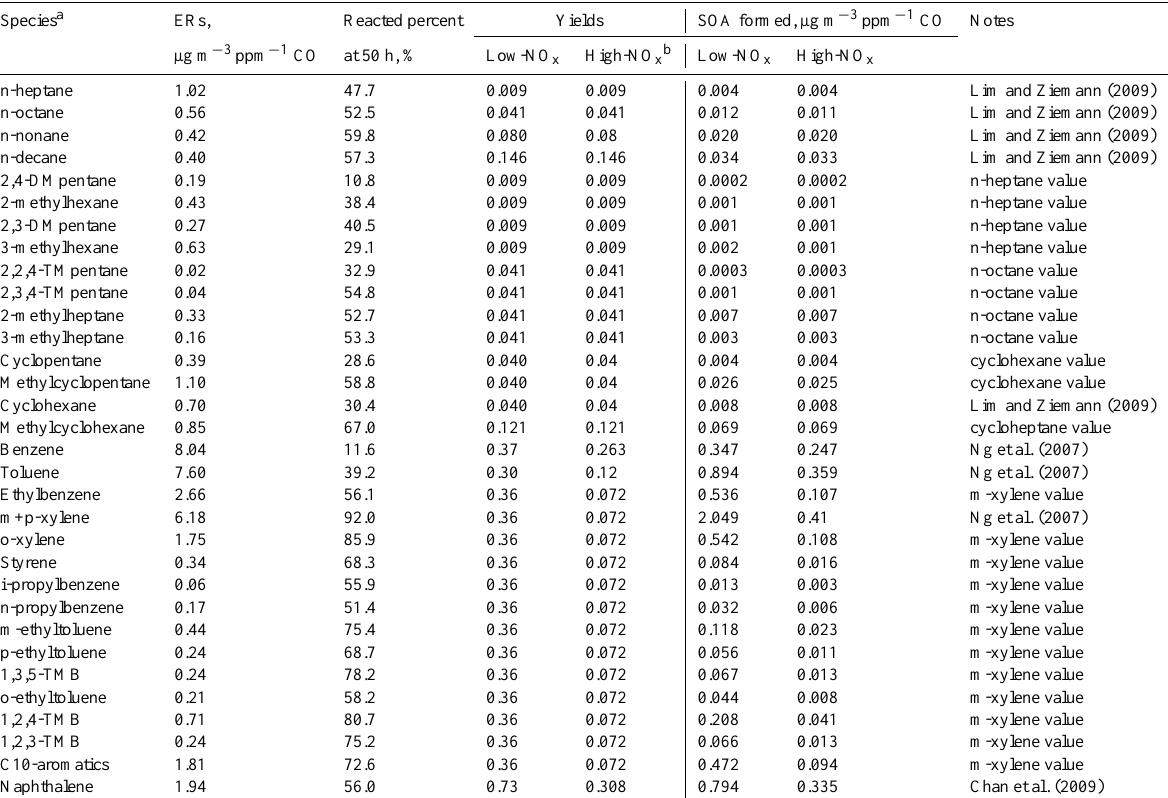
Table 4. Emission ratios of various VOC species, the percentages of reacted VOCs after 50 h photochemical reactions, SOA yields and the SOA masses formed after 50 h